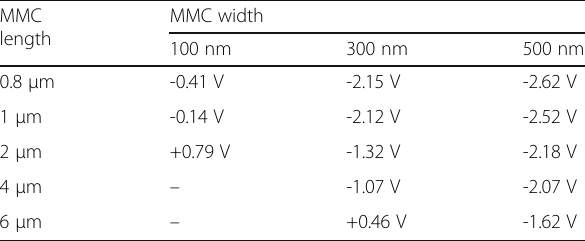
Table 1 Threshold voltages of HEMTs having MMC structures of various lengths and widths, measured at a drain current of 1 mA/mm MMC